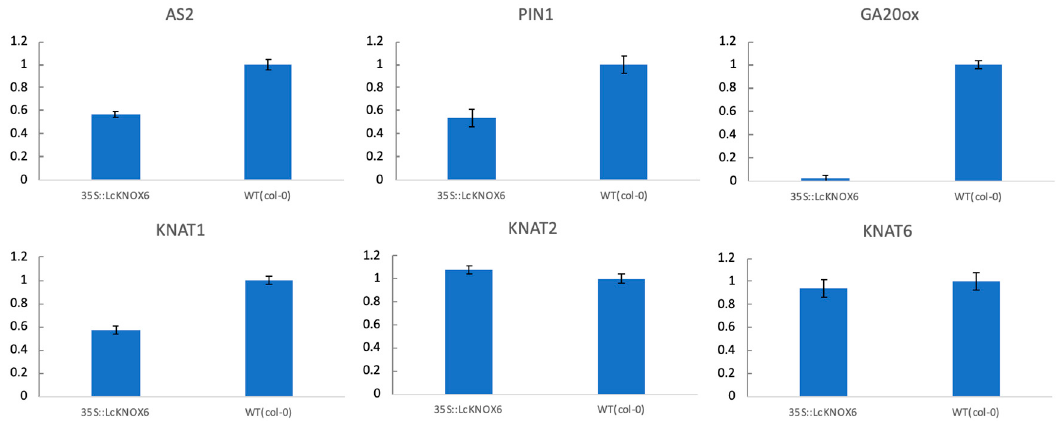
Figure 5. The expression of genes that may be regulated by the KNOX protein in 35S::LcKNOX6 A. thaliana ( n = 3 replications for each validation).